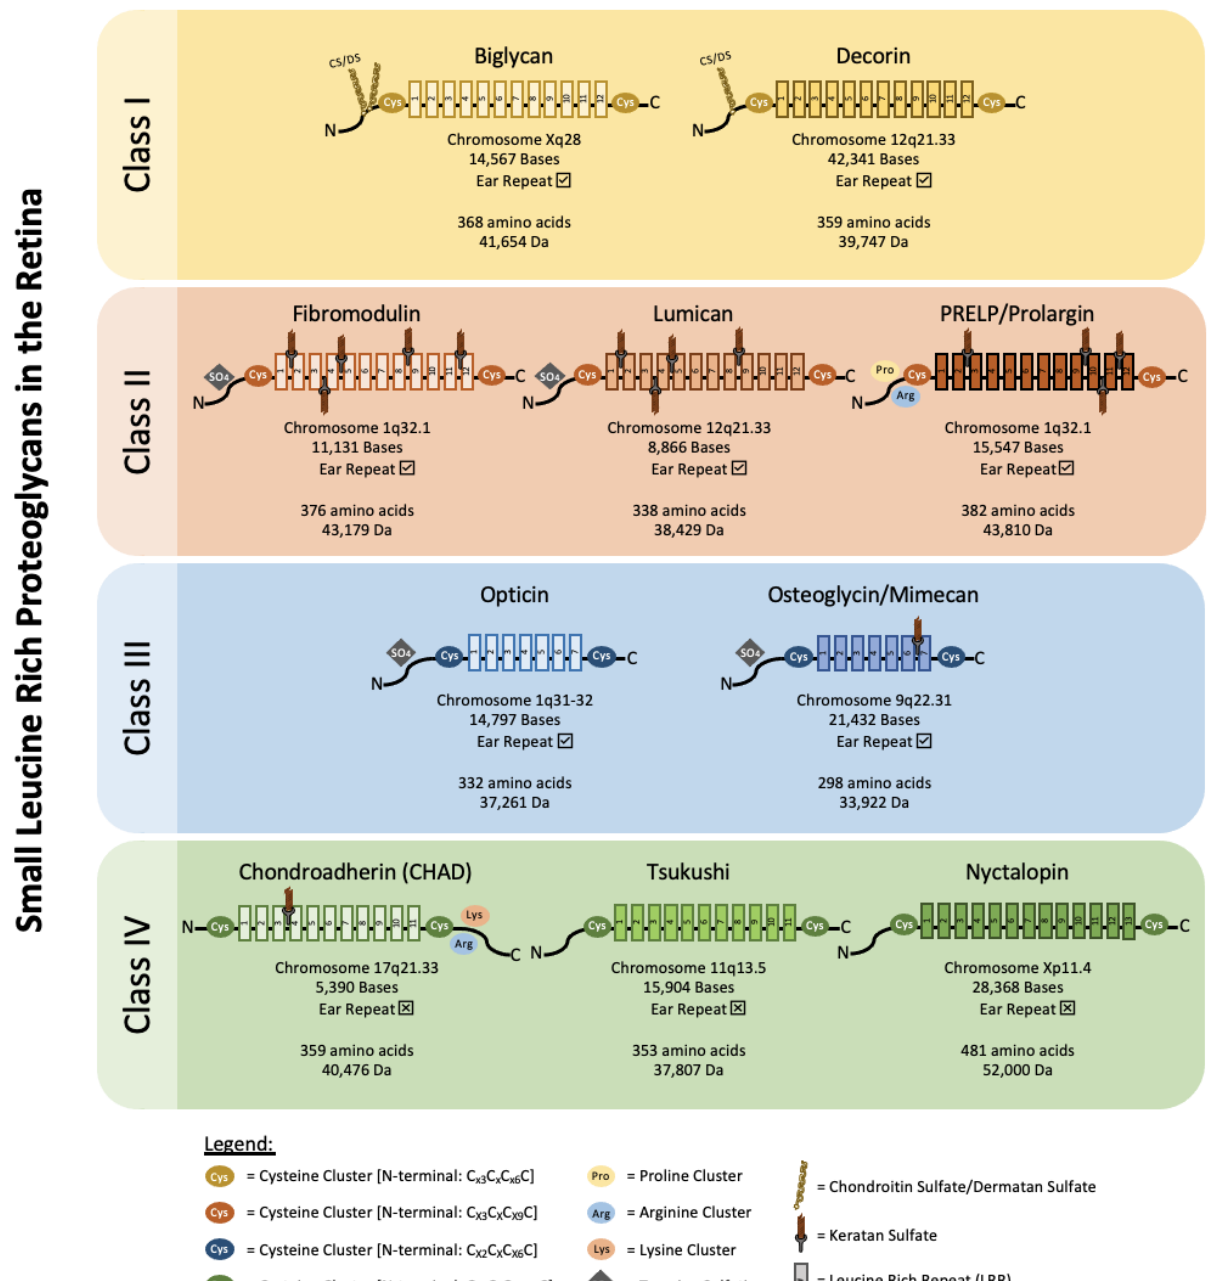
Figure 1. Classification and gene–protein information of known retinal SLRPs. Biglycan and decorin belong to class I SLRPs. They harbor chondroitin or dermatan sulfate side chains and have a protein core made of 12 LRRs. Their N-terminal cysteine clusters follow the sequence C x3 C x C x6 C. Fibromodulin, lumican, and PRELP/Prolargin belong to class II SLRPs. Class II SLRPs contain N-linked keratan sulfate and also have a protein core made of 12 LRRs. Their N-terminal cysteine cluster has the sequence C X3 C X C X9 C. Opticin and osteoglycin/mimecan are class III SLRPs. They both have a protein core made of 7 LRRs and a N-terminal cysteine cluster sequence of C X2 C X C X6 C. Osteoglycin/mimecan has a N-linked keratan sulfate side chain. Fibromodulin and lumican from class II and opticin and osteoglycin/mimecan from class III have clusters of tyrosine sulfate residues near their N-terminus. Chondroadherin (CHAD), tsukushi, and nyctalopin are class IV SLRPs. They have a protein core made of 11–13 LRRs and a N-terminal cysteine cluster sequence of C X3 C X C X6-17 C. Class IV SLRPs do not have ear repeats. CHAD harbors a N-linked keratan sulfate side chain, and clusters of lysine and arginine at its C-terminus. Molecular weight represents SLRP core proteins without glycosylation.